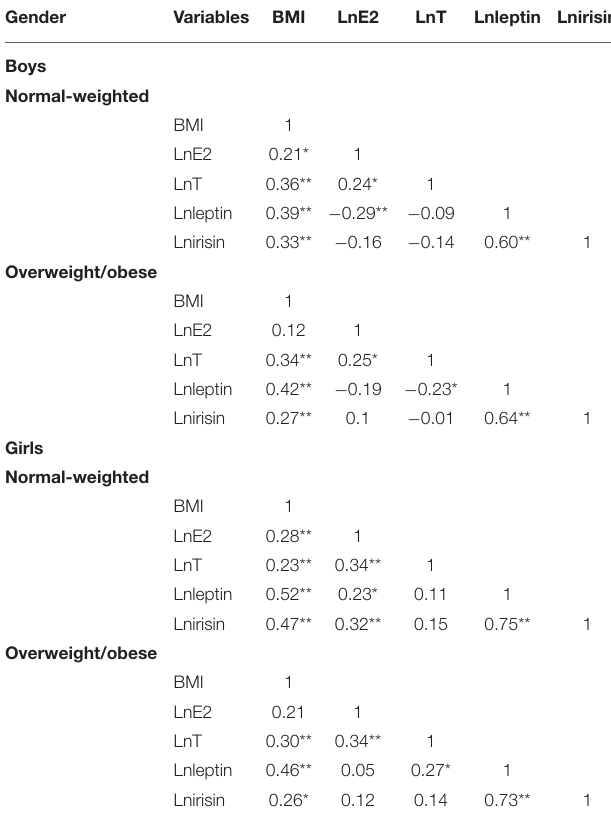
TABLE 2 | Correlation coefficient between body mass index (BMI), testosterone (T), oestradiol (E2), leptin, and irisin in children and adolescents with different body types.